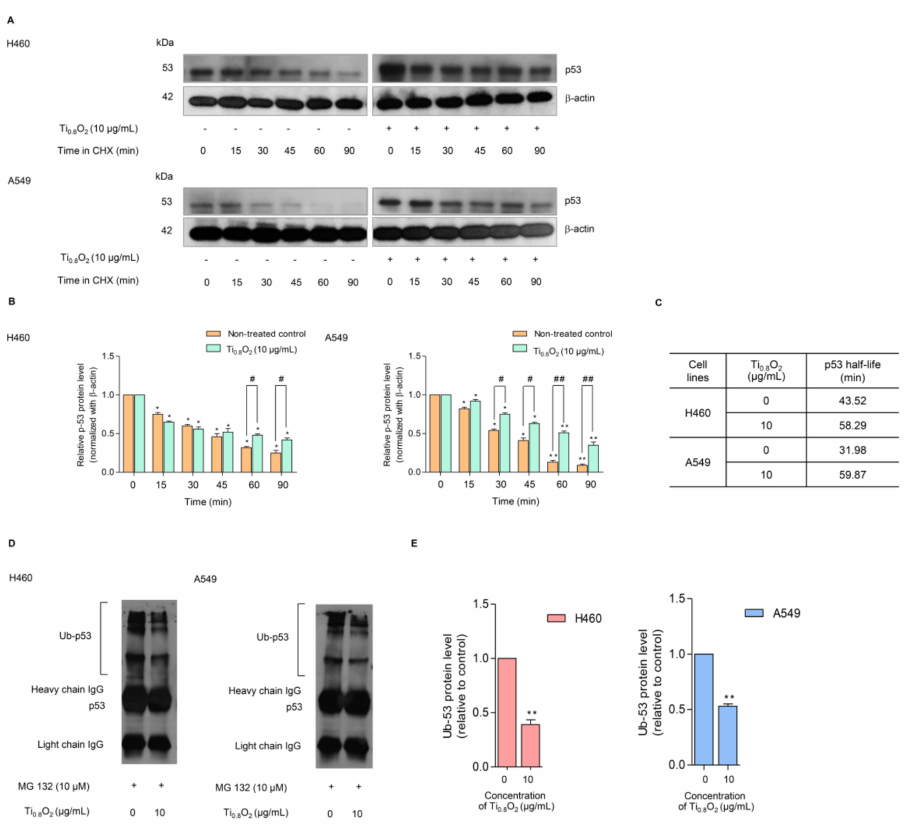
Figure 8. Effect of Ti 0.8 O 2 nanosheets on the p53 level and proteasomal degradation. ( A ) The cycloheximine (CHX) chasing assay was performed to determine the half-life of p53. H460 and A549 cell lines were treated with 50 µ g/mL of CHX with or without 10 µ g/mL Ti 0.8 O 2 nanosheets. Western blot analysis was used to determine the p53 protein level; ( B ) the relative p53 protein levels were calculated and compared with the control group at 0 min; ( C ) the half-lives of the p53 protein of H460 and A549 cells were calculated; ( D ) H460 and A549 cells were pretreated with 10 µ M MG132 for 30 min, followed by treatment with 10 µ g/mL Ti 0.8 O 2 nanosheets for 60 min. The protein lysates were collected, and the p53 protein was pulled down using p53 antibodies. The levels of the ubiquitin-p53 protein complex were determined by Western blot analysis.; ( E ) p53-ubiquitin complexes were quantified by densitometry. The relative protein levels are reported ( n = 3). * p < 0.05, ** p < 0.01 compared with the untreated control at 0 min, and # < 0.05, ## p < 0.01 compared with the untreated control at the same